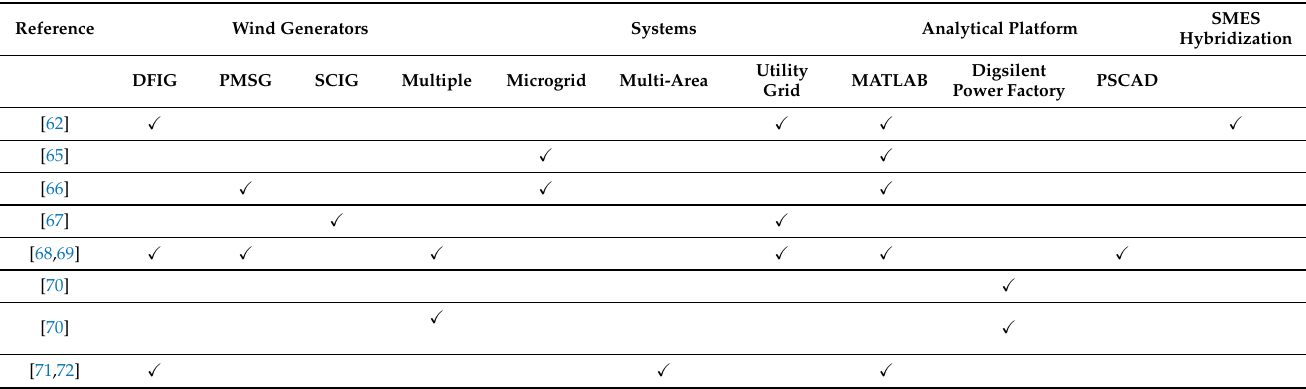
Figure 4. Dynamic model of SMES along with FOC. Table 1. Summary of SMES technologies for wind system frequency